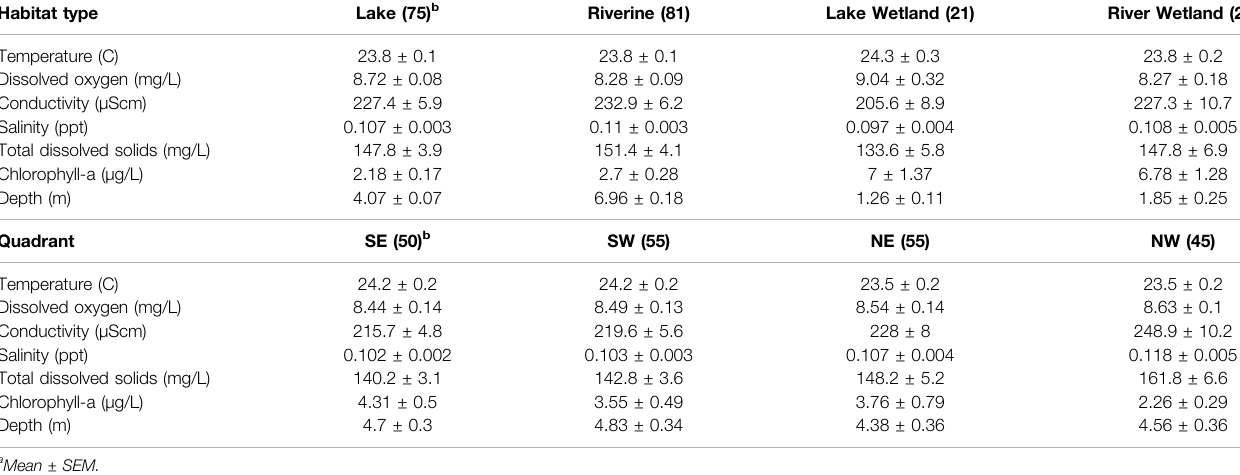
a Mean ± SEM. b (sample size).